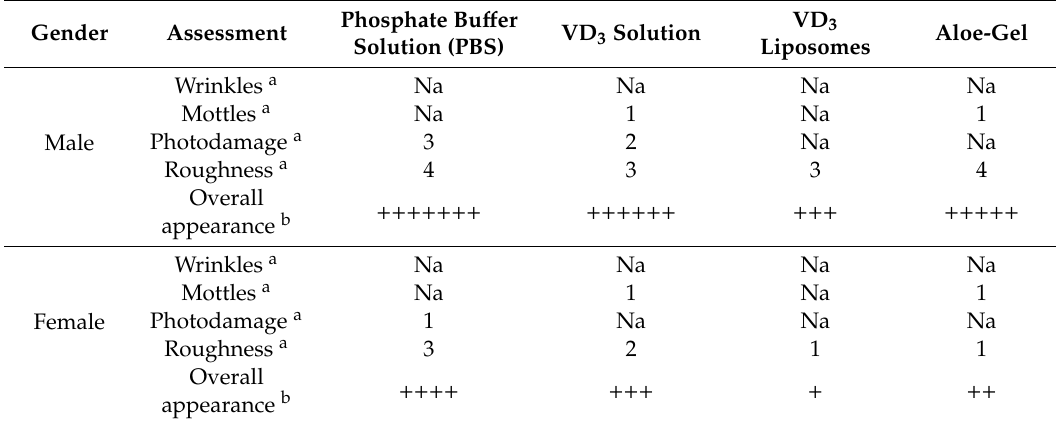
Figure 5. The histology of skin by H&E staining of the skin tissue section. ( A ) Control, normal skin ( B ) Photoaging model, ( C ) Treatment with VD 3 solution, ( D ) Treatment with VD 3 liposomes, ( E ) Treatment with aloe-gel as positive control ( F ) Treatment with PBS. H&E 200x.